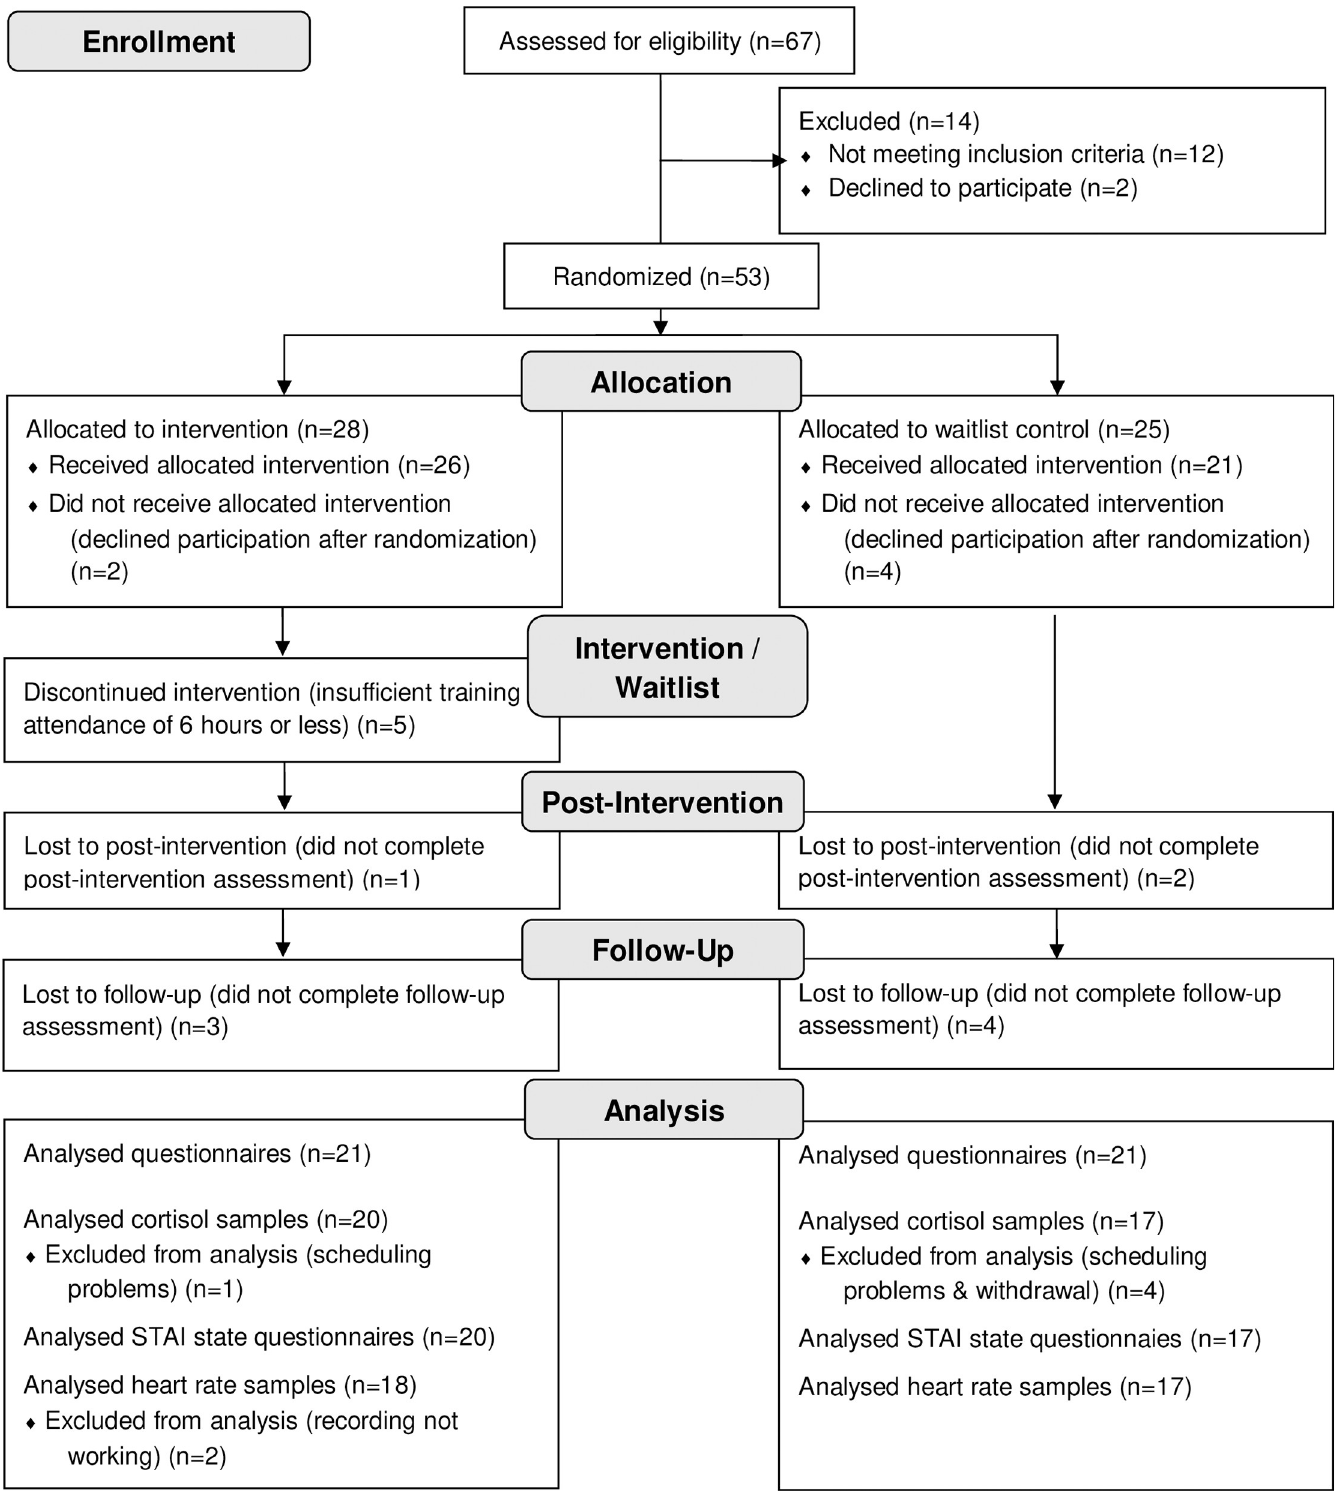
Fig 1. Recruitment and participants flow through the study.